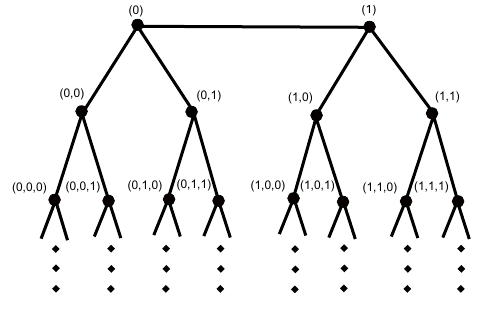
Figure 3: Cantor binary tree T 2 ω